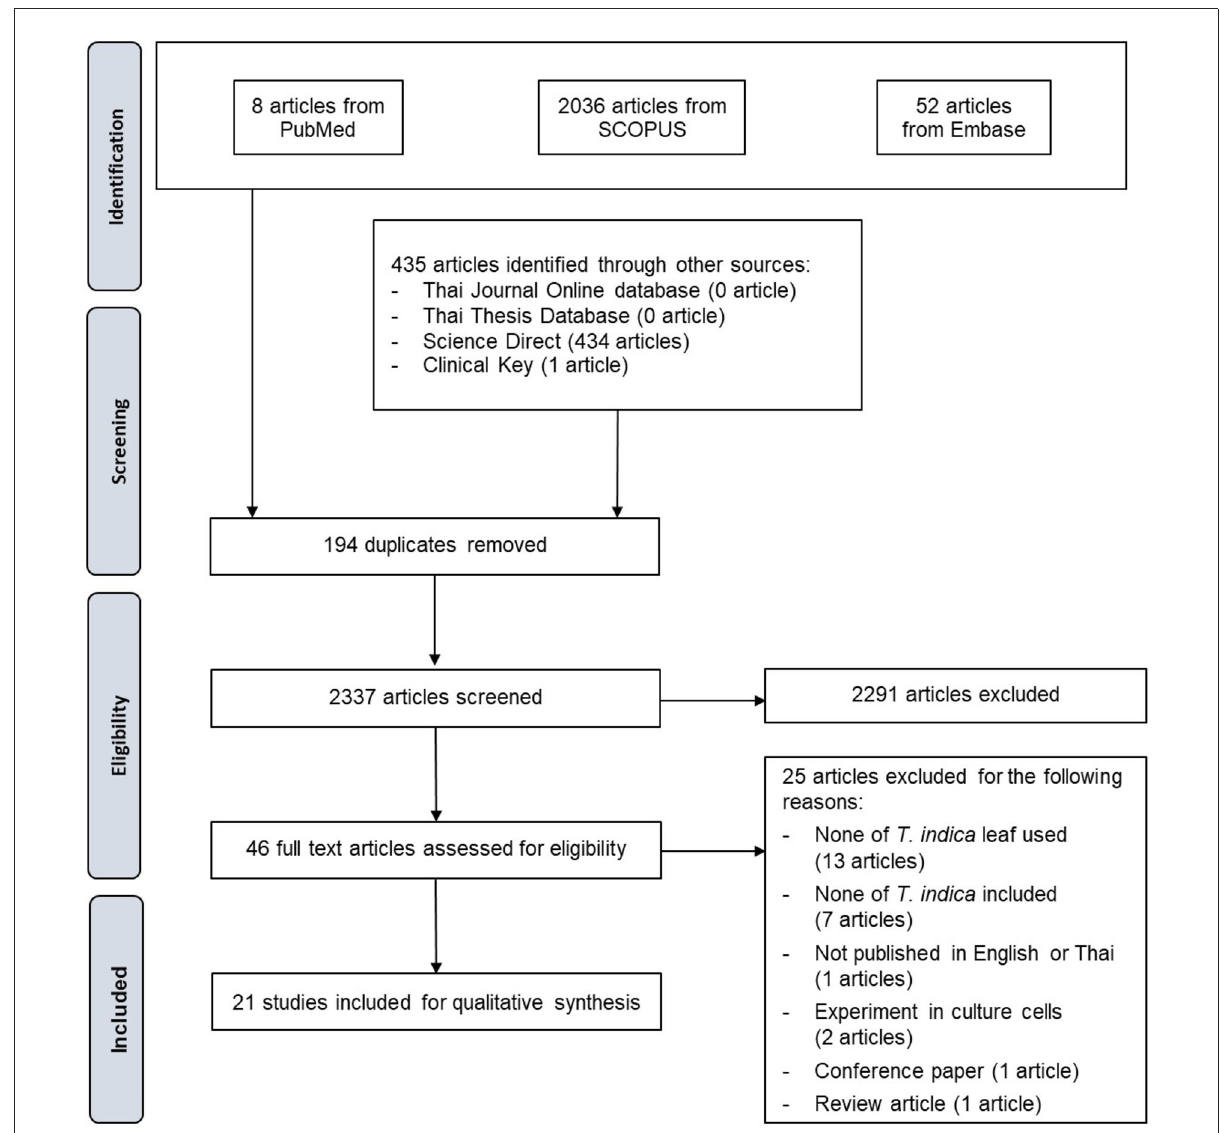
FIGURE1 PRISMA flow diagram of the study selection